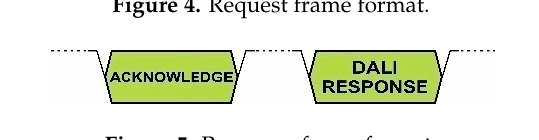
Figure 5. Response frame format.